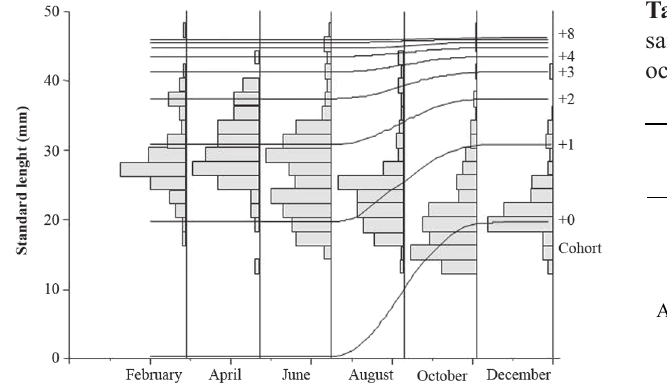
Fig. 7. Bimonthly energy expenditure during cycles of mexcalpique nictemeral in San Martin.